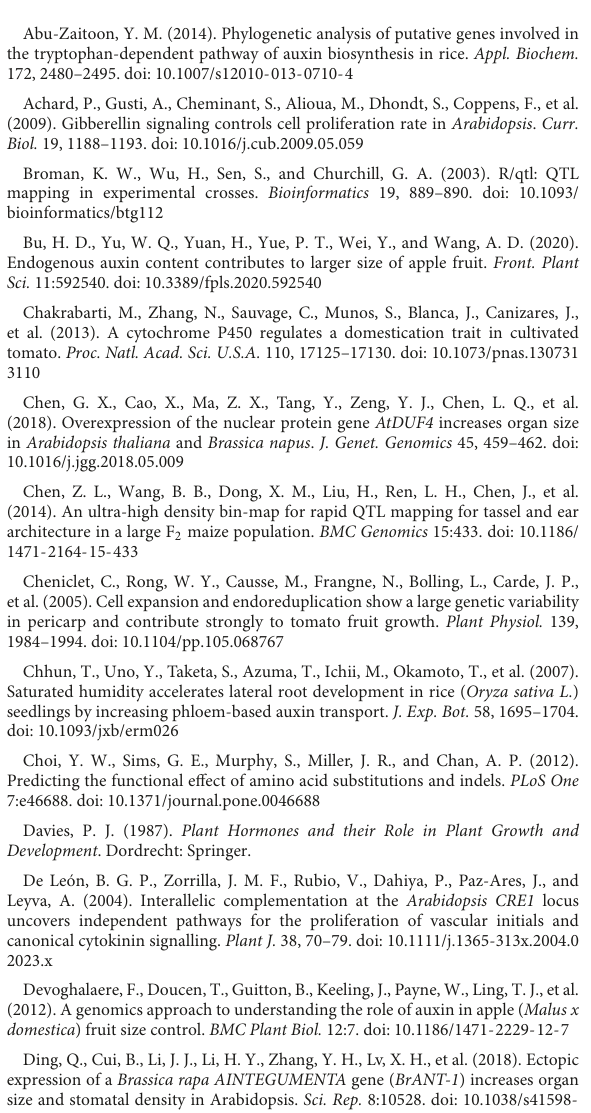
Figueiredo, D. D., and Köhler, C. (2018). Auxin: a molecular trigger of seed development. Gen. Dev. 32, 479–490. doi: